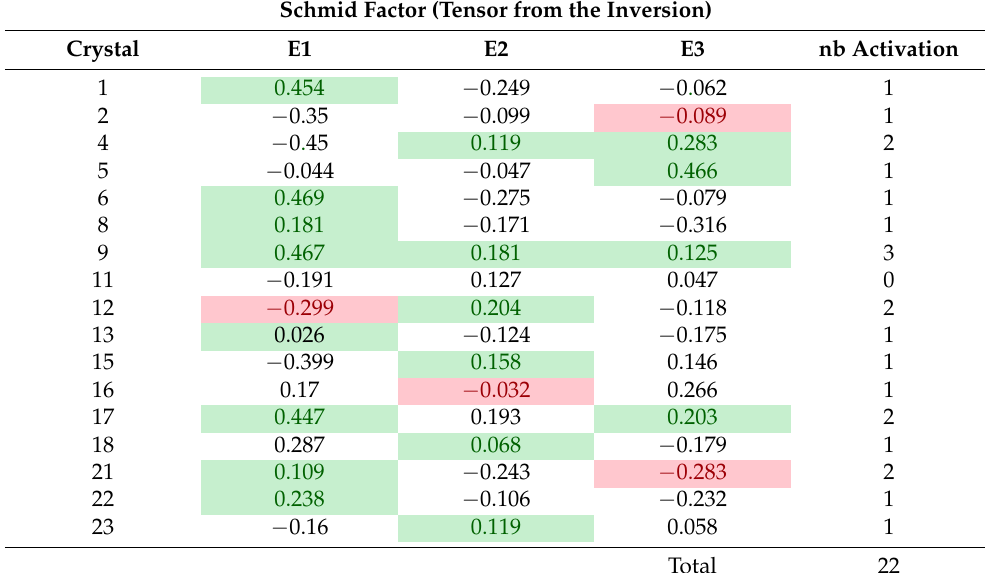
Table 1. In the first column is the numbering of the crystals that can be found in Figure 6. Columns E1, E2 and E3 represent the twin planes and their Schmid factors, which result from the inversion of the data. In green, the twinned planes compatible with the tensor and in red, the twinned planes incompatible with the tensor. The rest is the list of Schmid factors for the twin planes not activated in the experiment. The last column counts the number of families of activated twin